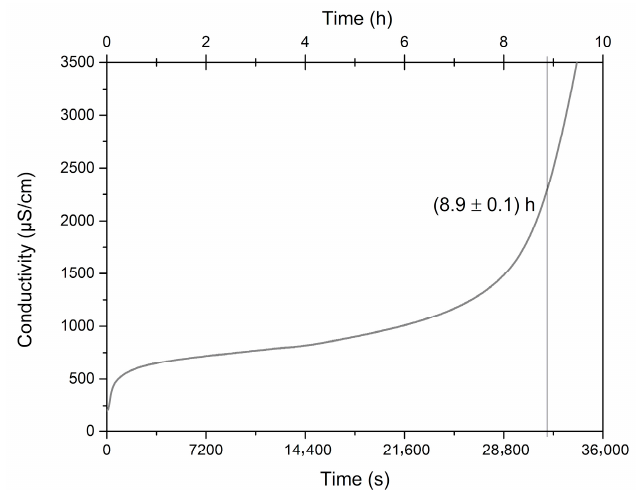
Figure 4. Electrical conductivity versus time determined by the Rancimat method in Caryocar brasiliense oil.